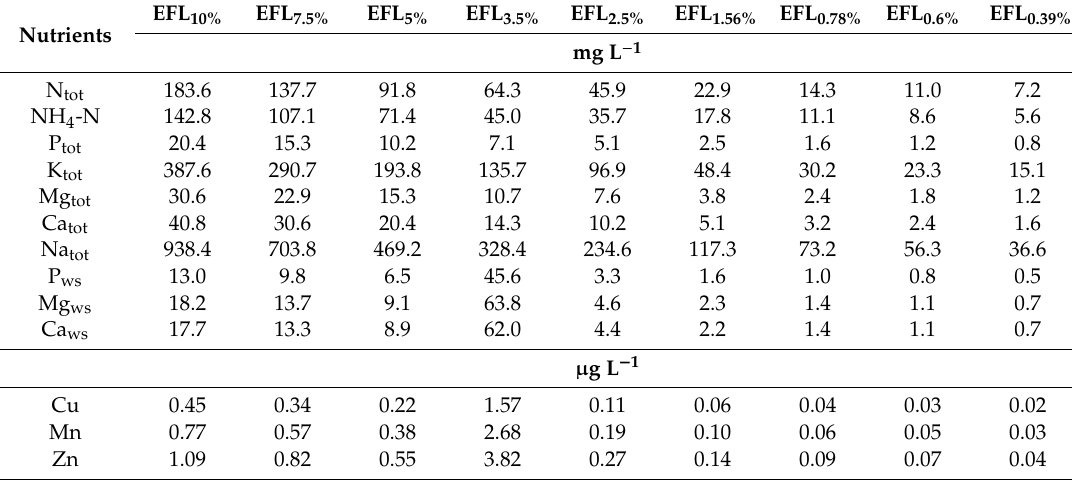
Table 3. Initial nutrient concentrations in growth media with di ff erent concentrations of the e ffl uent from the biorefinery